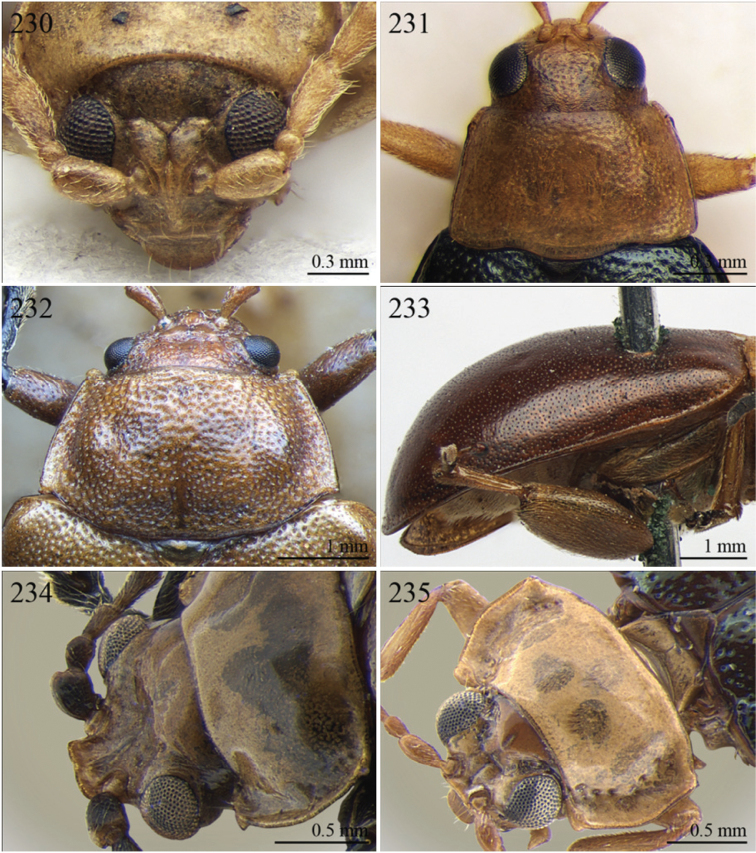
Morphological characters. 230
Phygasia sulphuripennis Jacoby, head in frontal view 231
Phyllotreta natalensis Jacoby, head and pronotum in lateral view 232
Physodactyla rubiginosa (Gerstaecker), head and pronotum in lateral view 233
Physodactyla gerstaeckeri (Jacoby), elytra in lateral view 234
Physoma atripes (Fairmaire), head in sublateral view 235
Physoma costuliferum Bechyné, head in sublateral view.